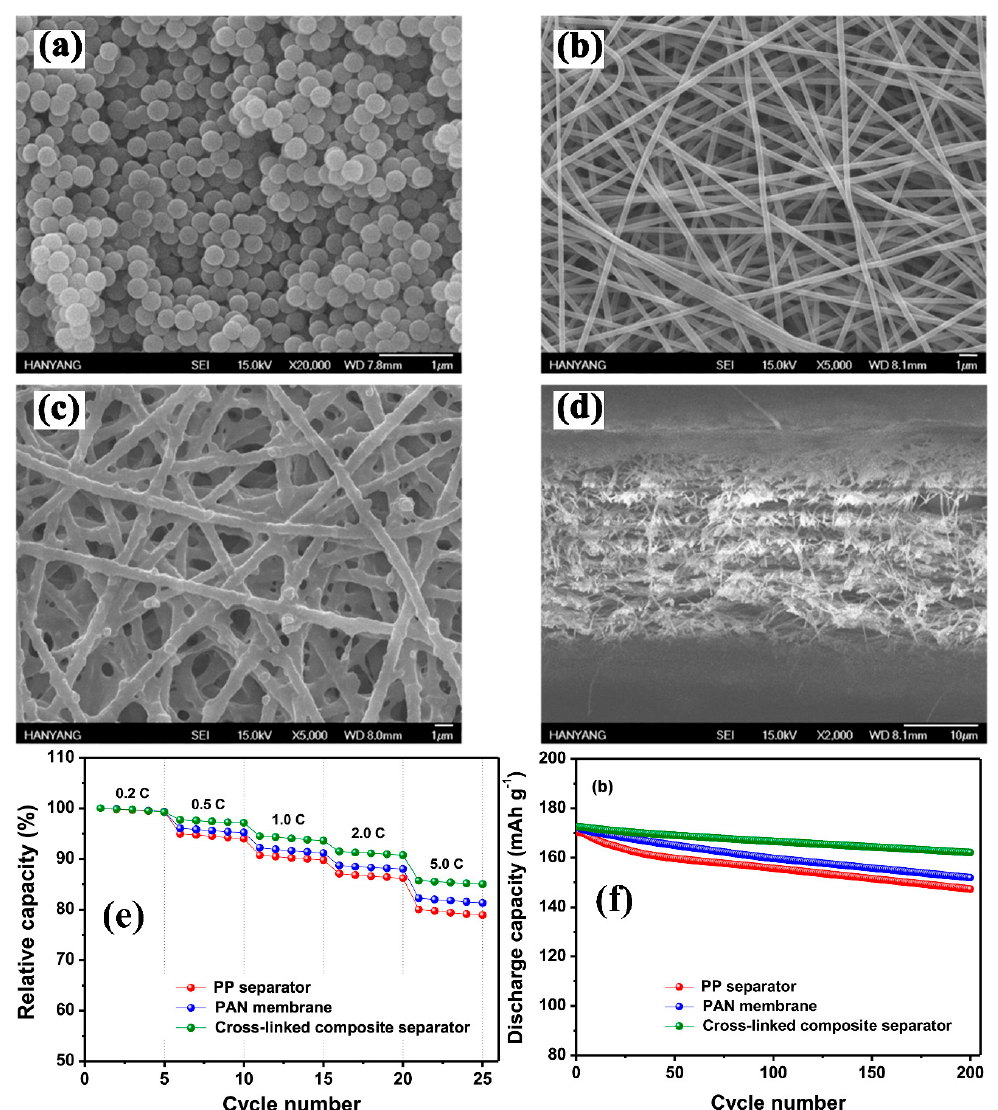
Figure 5. ( a ) SEM of reactive SiO 2 particles, ( b ) Top view of PAN fiberous separator, and ( c ) composite separator cross linked with SiO 2 ( d ) cross-sectional view of the crosslinked composite separator ( e ) discharge capacities of different separators at different C rates (ambient temperature) ( f ) cycling capacities of separator a 0.5 C rate for 100 cycles [98], with copyright permission from Elsevier.